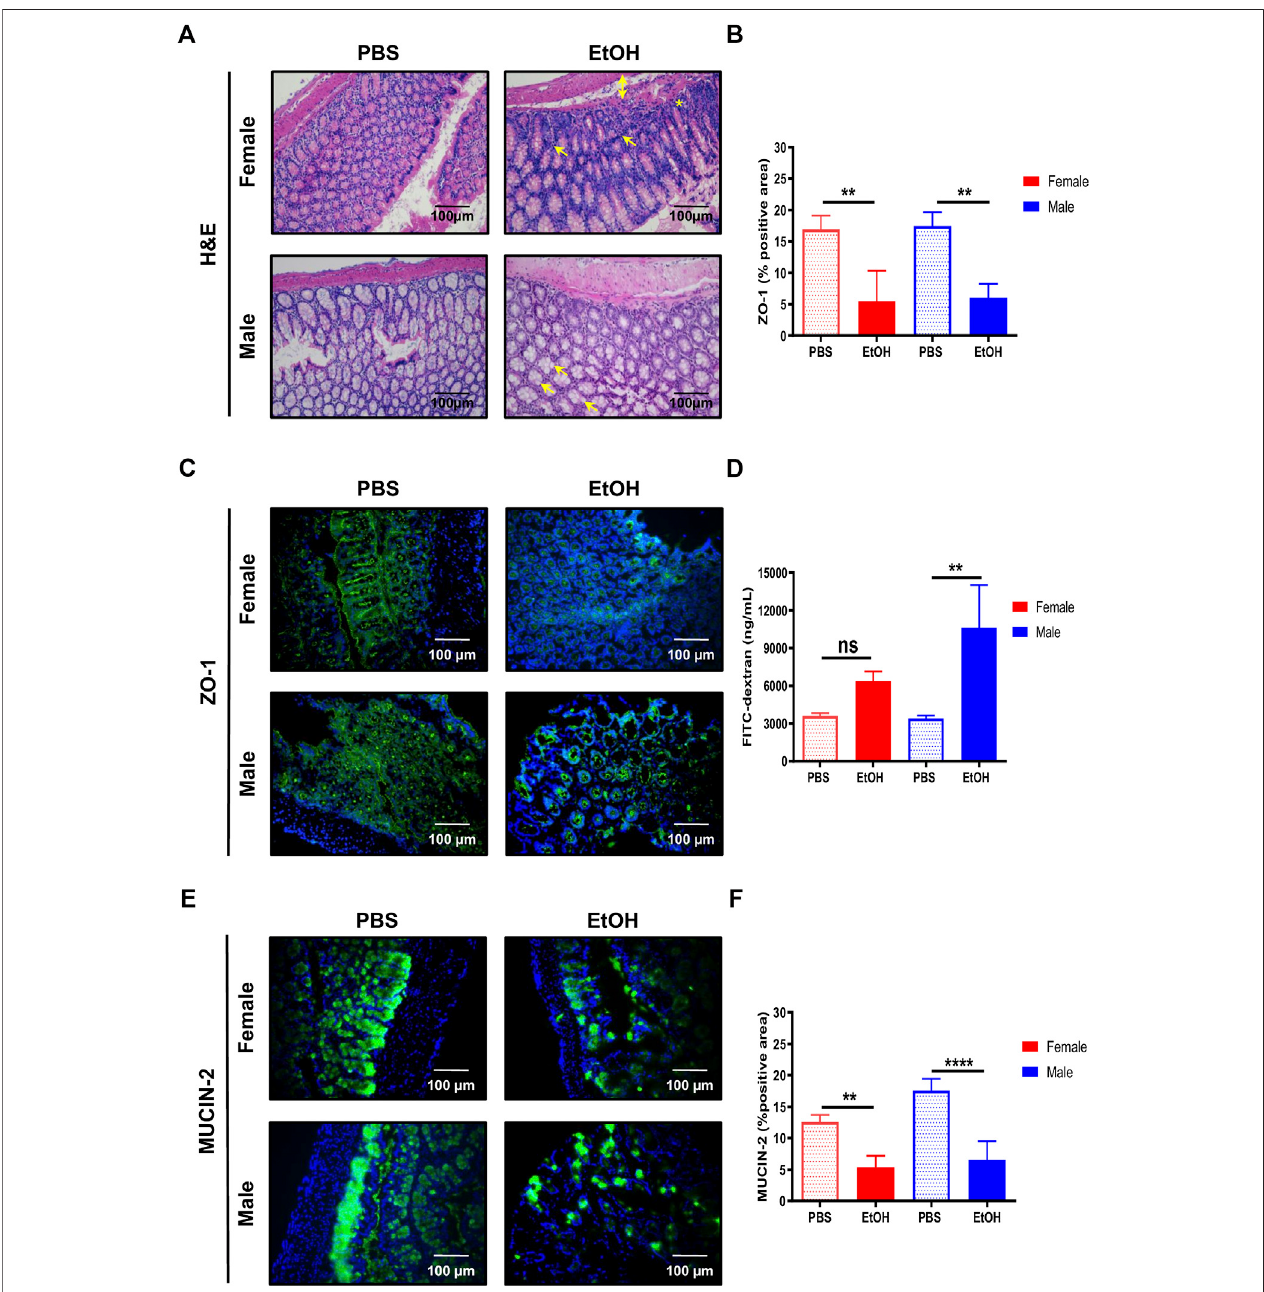
FIGURE1| Acutealcoholinjurydisruptsthegutintestinalbarrierinfemaleandmalemice. (A) RepresentativeH&Estainingwasperformedinparaf fi ncolonsections of female and male mice treated with EtOH [6 g/kg] or PBS ( n (cid:1) 5 – 7/group). (B) Quanti fi cation of the ZO-1 positive area was performed and graphed ( n (cid:1) 4/group). (C) ZO-1 immuno fl uorescence staining was performed in colons of male and female mice. (D) FITC-dextran levels in serum from female and male mice was quanti fi ed as a measureofintestinalpermeability( n (cid:1) 3 – 4/group). (E) MUCIN-2 immuno fl uorescence stainingwasperformedincolonsoffemaleand malemice. (F) Quanti fi cation oftheMUCIN-2positiveareawasdoneandgraphed( n (cid:1) 4 – 5/group;** p < 0.01,**** p < 0.0001).Infemalemice,arrowsmarkmixedin fl ammation;doublearrow,oedema in submucosa and a star, degeneration of crypt basal cells. In male mice, arrows mark mild hypertrophy in Goblet cells.